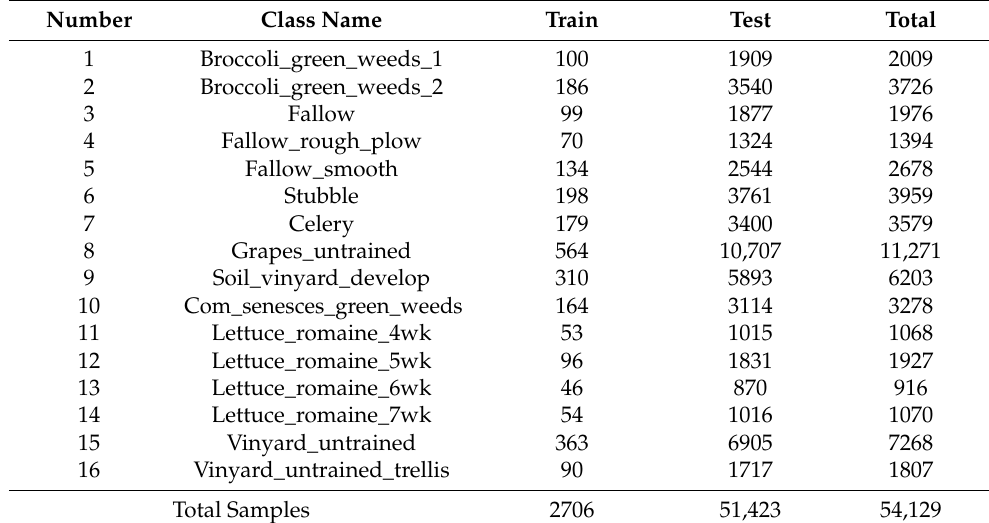
Table 3. Number of training and testing samples for the Salinas